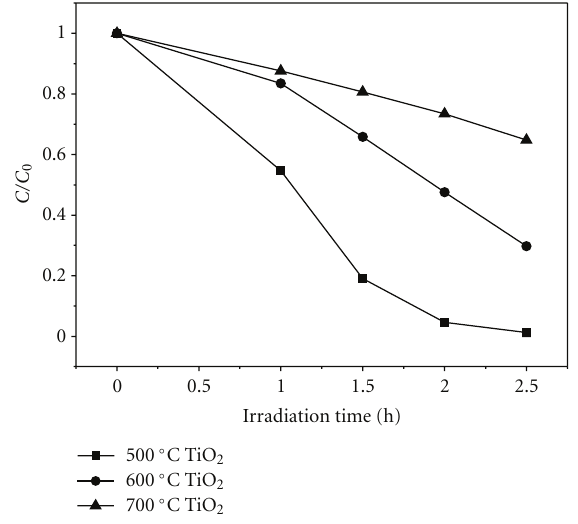
Figure 6: Photodegradation rate of RhB solution in the presence of the as-prepared TiO 2 nanofibers obtained at 500 ◦ C (solid square), 600 ◦ C (solid circle), and 700 ◦ C (solid triangle) under visible